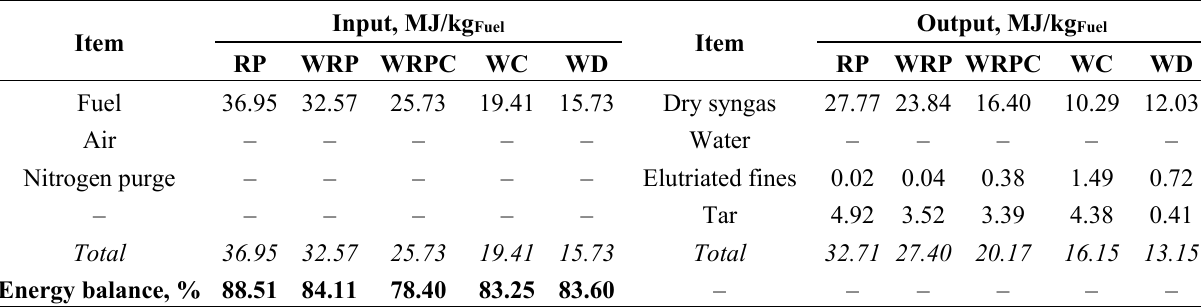
Table 7. Energy balance performed during the gasification